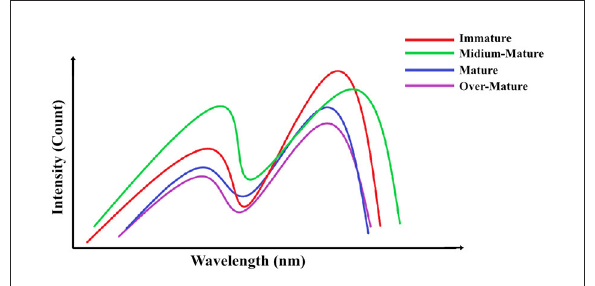
FIGURE3 The spectral patterns of products at various stages of